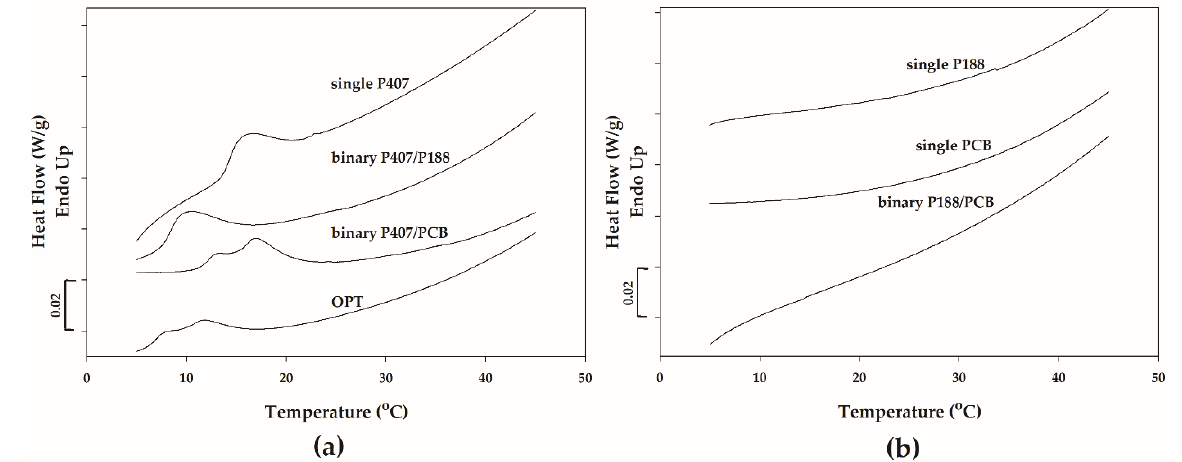
Figure 4. DSC thermograms of ( a ) OPT, 20.000% P407 (single P407), the mixture of 20.000% P407 and 7.349% P188 (binary P407/P188) and the mixture of 20.000% P407 and 0.595% PCB (binary P407/PCB), and ( b ) 7.349% P188 (single P188), 0.595% PCB (single PCB) and the mixture of 7.349% P188 and 0.595% PCB (binary P188/PCB).